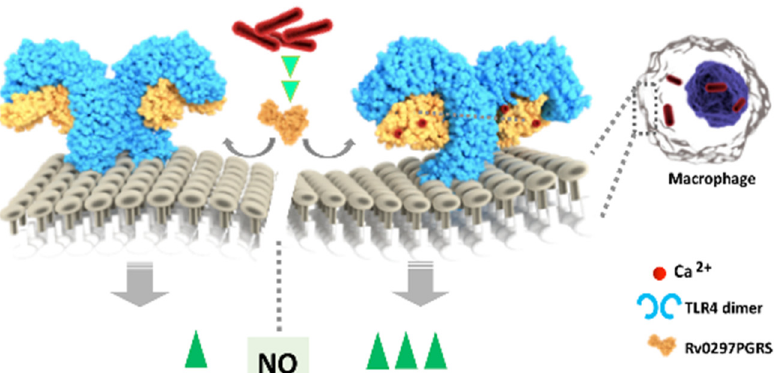
Figure 8. Schematic representation of Calcium dependent functions of Rv0297PGRS. The binding of Ca 2+ with Rv0297PGRS stabilizes the protein and enhances its interaction with TLR4 of macrophages. The Ca 2+ stabilized binding of Rv0297PGRS with the macrophage surface receptor of macrophages increases the production of NO and pro-inflammatory cytokines. These calcium binding motifs in the PGRS domain may aid in the stabilization of the unstructured/disordered PE_PGRS proteins, involved in virulence and pathogenesis of tuberculosis.